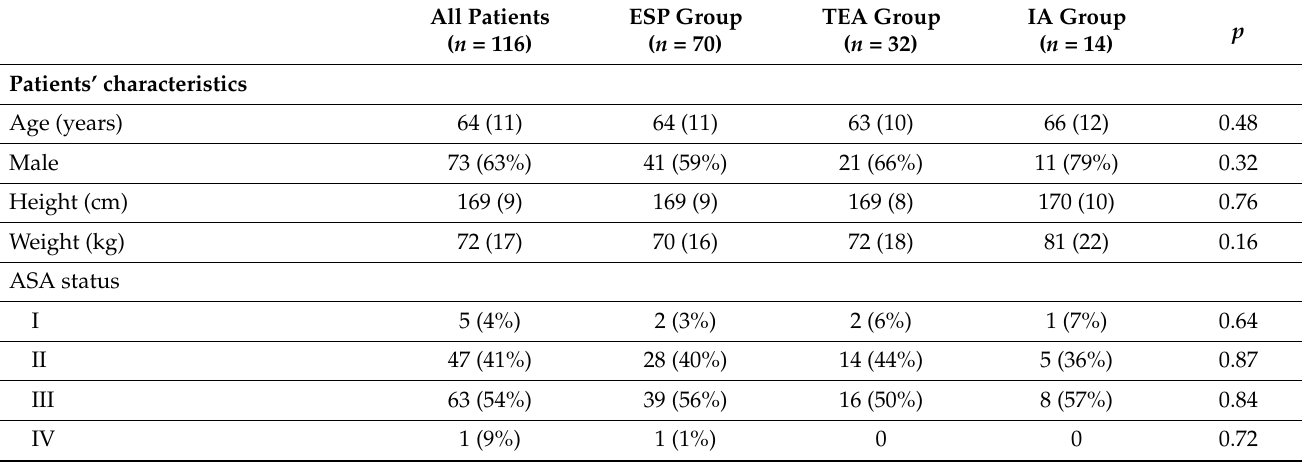
Table 1. Preoperative